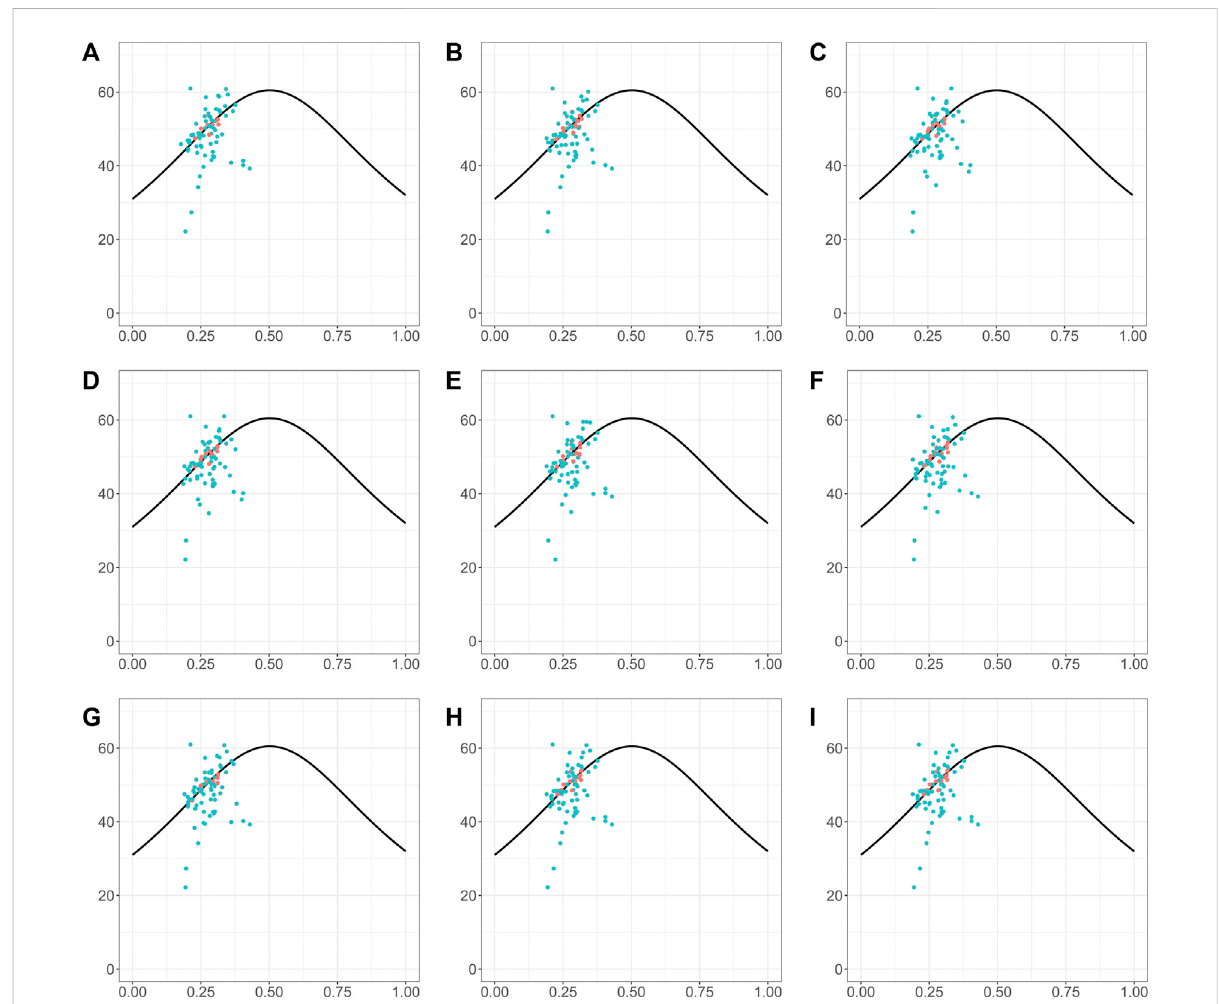
FIGURE 8 TheENc-GC3plotofdifferent Piper species.Thesolidlinerepresentstheexpectedcurveofpositionsofgeneswhenthecodonusagewasonly determined by the GC3s composition. The red dots highlighted the screened markers. (A) P. nigrum ; (B) P. boehmeriifolium ; (C) P. austrosinese ; (D) P. mutabile ; (E) P. bonii ; (F) P. betle ; (G) P. retrofractum ; (H) P. hainanense ; (I) P. umbellatum